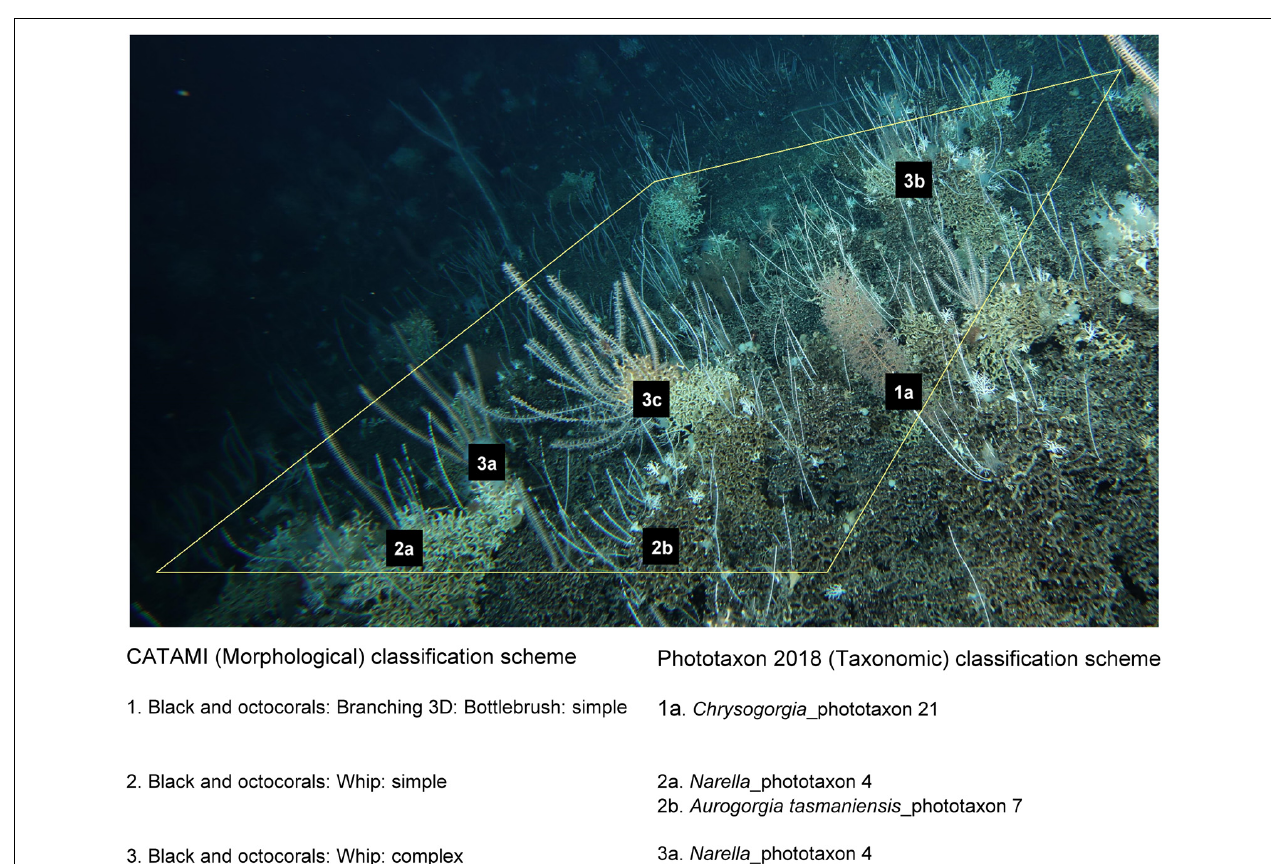
FIGURE 4 | Example of the CATAMI morphological and Phototaxa 2018 taxonomic classification schemes for black and octocorals. These two schemes were used together in the dual annotation method.